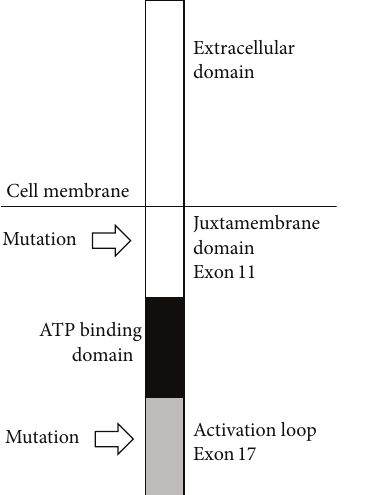
Figure 5: Schematic diagram of the intra- and extracellular KIT protein domains coded for by various exons as well as the mutations in exons 11 and 17 seen in our